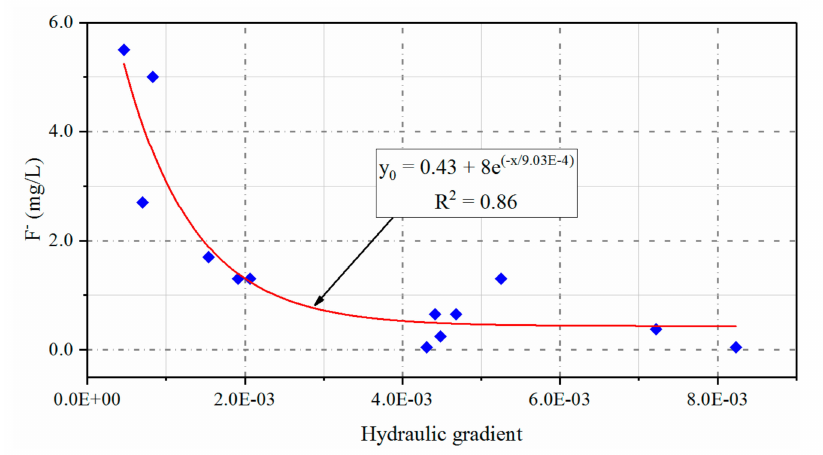
Figure 5. Influence of hydraulic gradient on fluorine in groundwater of the Jiaolai Basin, Jiaodong Peninsula, eastern